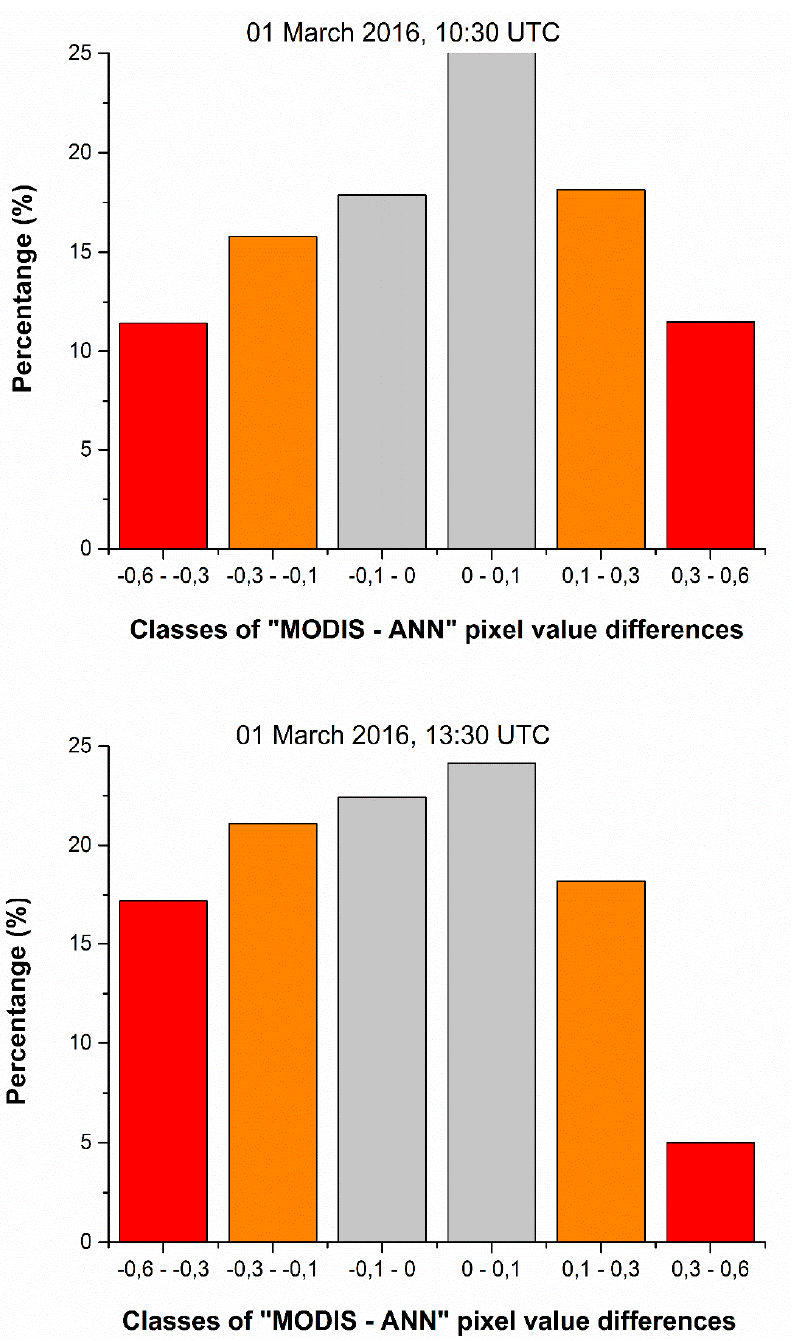
Figure 9. Histogram distributions of differences between the matched 1° × 1° pixel-level AOD 550 nm data of MODIS-Terra (10:30 UTC) and MODIS-Aqua (13:30 UTC) and the ANN model for 1 March 2016.